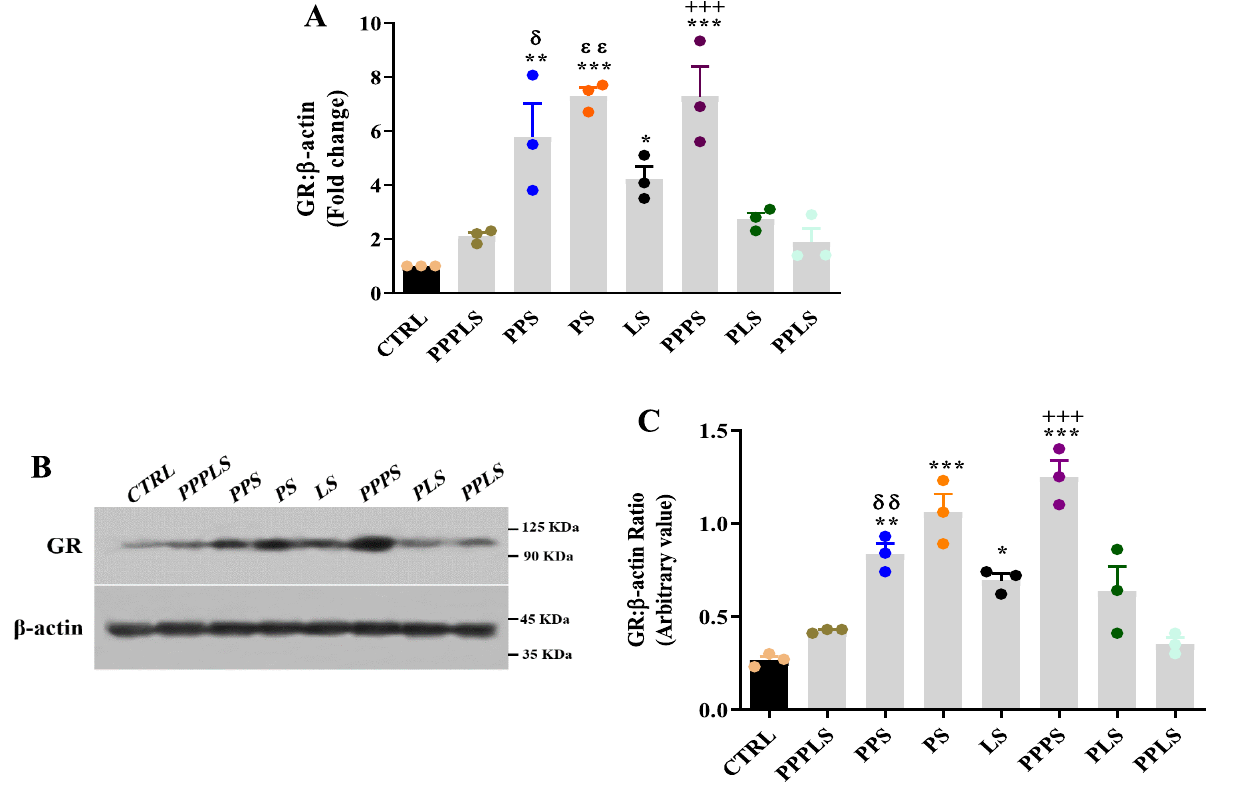
Figure 6. Effect of perinatal stress on pancreatic GR ( A ) protein ( B , C ) levels in the young adult male offspring. Each column represents mean ± SEM (3 rats/group, 3 litters/group). Data was analyzed using one-way ANOVA followed by Tukey’s post hoc test; * P < 0.05, ** P < 0.01, *** P < 0.001 versus CTRL group; +++ P < 0.001 versus PPPLS group; ɛɛ P < 0.01 versus PLS group; δ P < 0.05, δδ P < 0.01 versus PPLS group. CTRL non stress, PPPLS pre- pregnancy, pregnancy, lactation stress, PPS pre-pregnancy stress, PS pregnancy stress, LS lactation stress, PPPS pre-pregnancy, pregnancy stress, PLS pregnancy, lactation stress, PPLS pre-pregnancy, lactation